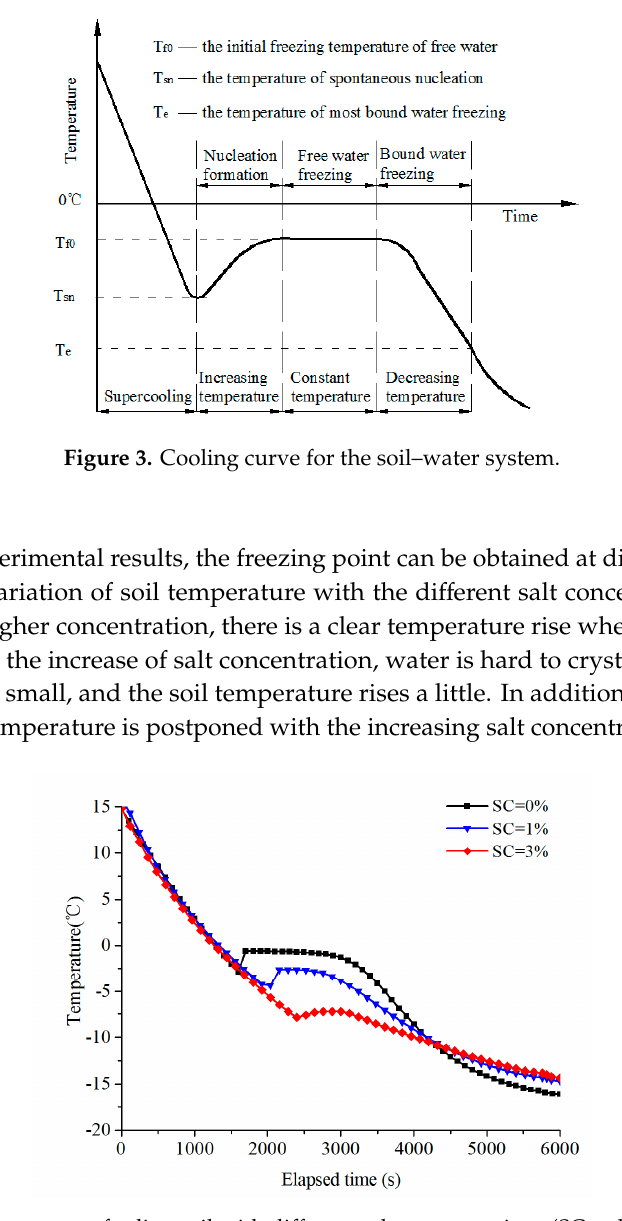
Figure 4. Cooling curves of saline soil with different salt concentrations (SC: salt concentration).